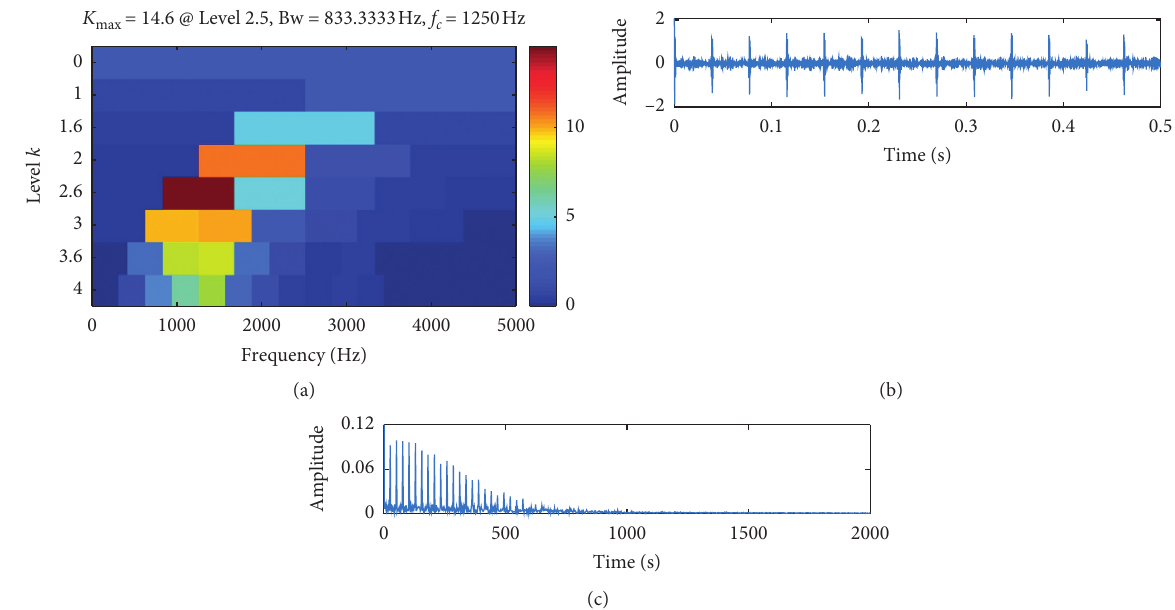
Figure 16: Processing results obtained using spectra kurtosis. (a) Fast Kurtogram; (b) filtered signal; and (c) envelope spectrum of signal in Figure 16(b).